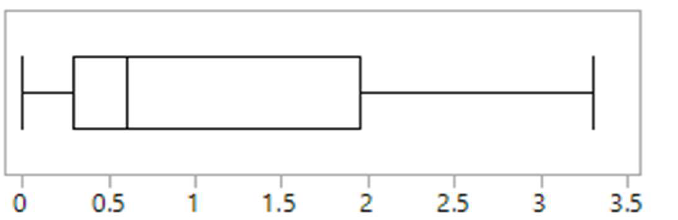
Figure 2. The proportion (%) of diagnosed eating disorders reported by Australasian tertiary, paediatric type 1 diabetes clinics ( n = 10). Vertical lines in boxplot (left to right) identify minimum, first quartile, median, third quartile and maximum values.